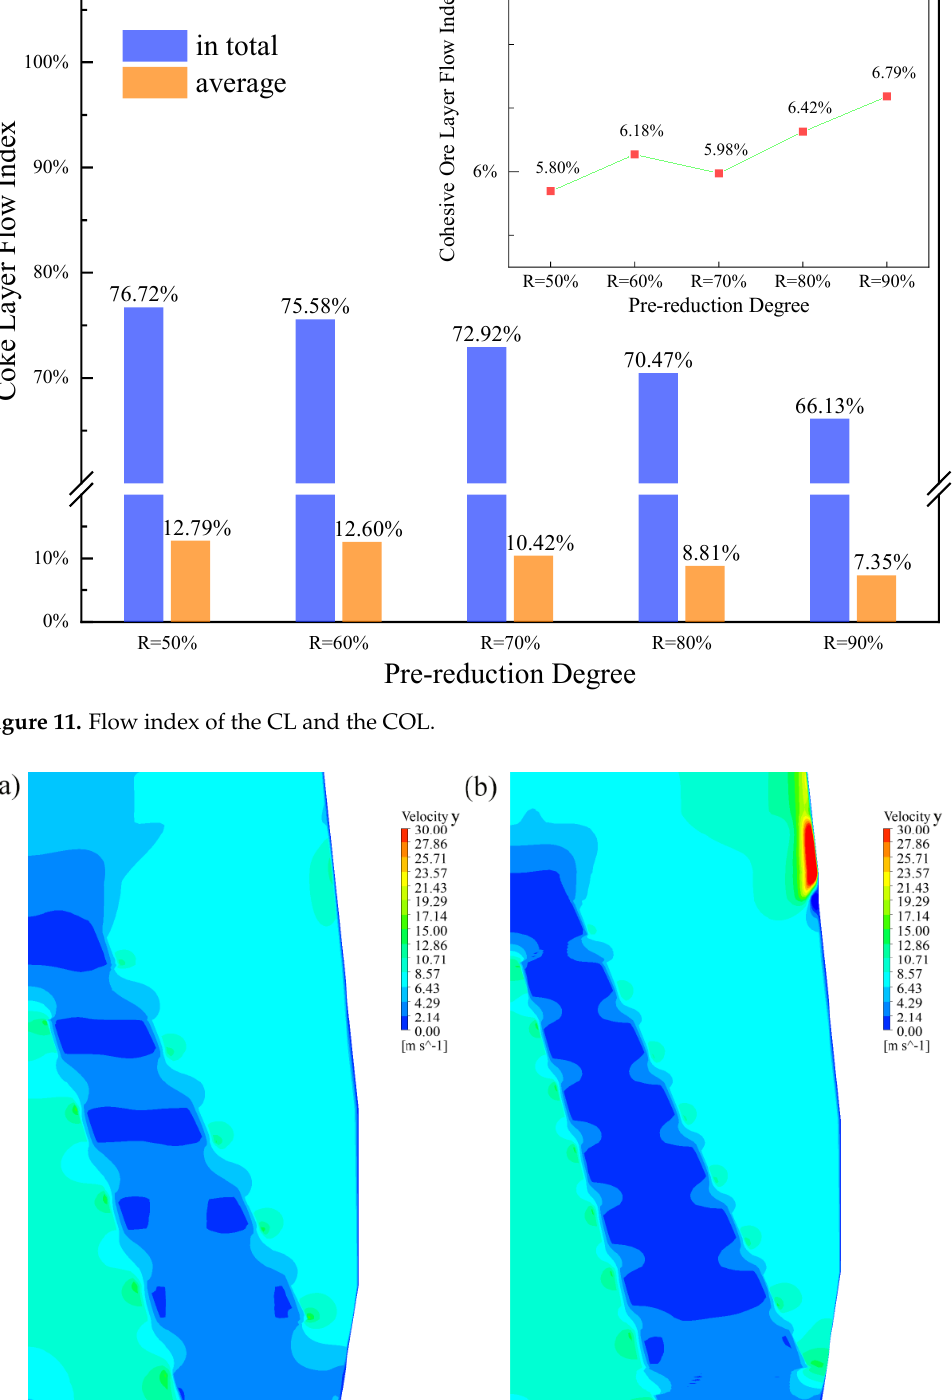
= 60°): ( a ) R = 50%, n = 6, ( b ) R = 𝛾𝛾